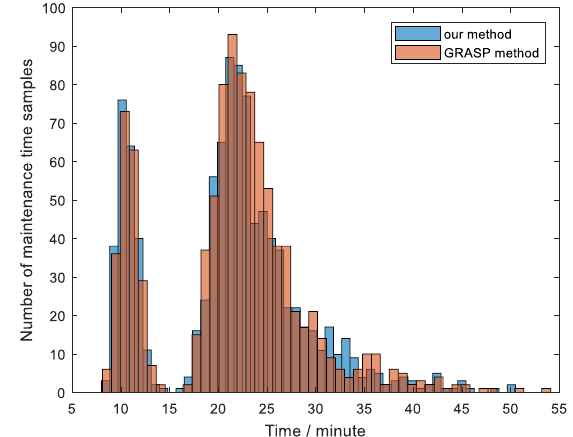
Figure 8. The histogram of maintenance time samples.